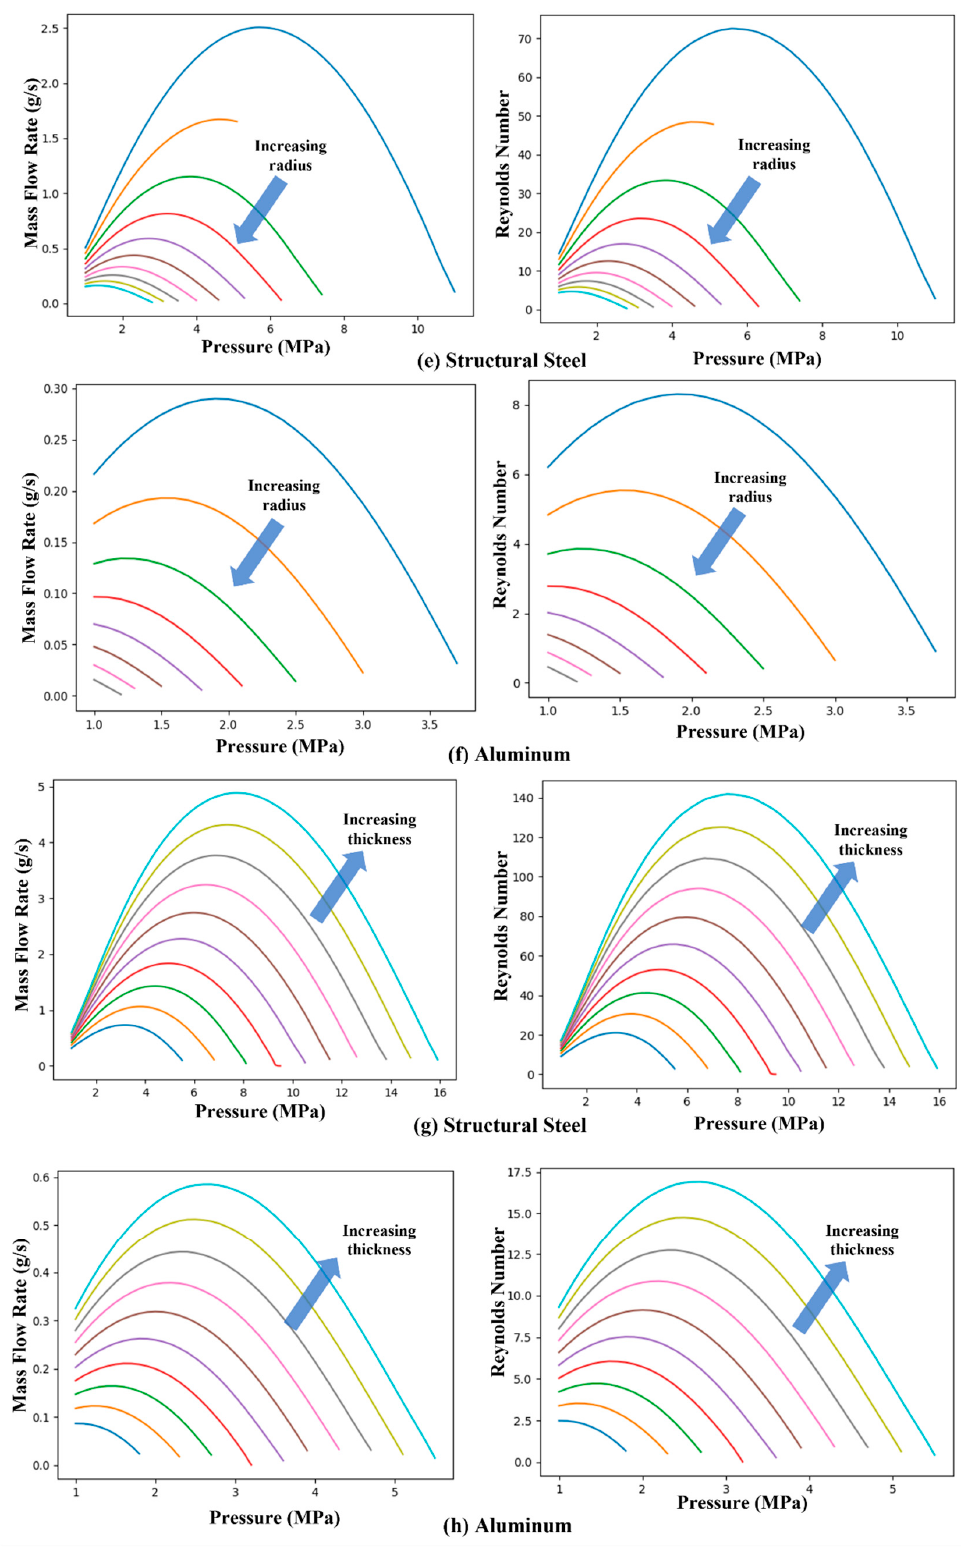
Figure 11. Variation of mass flow rates along with the associated Reynolds numbers for ( a , b ) increasing clearance for structural steel and aluminum; ( c , d ) increasing length for structural steel and aluminum; ( e , f ) increasing radius for structural steel and aluminum; ( g , h ) increasing thickness for structural steel and aluminum. The ranges of the parameters are listed in Table 2, and the simulations were conducted at 10 equal intervals in respective